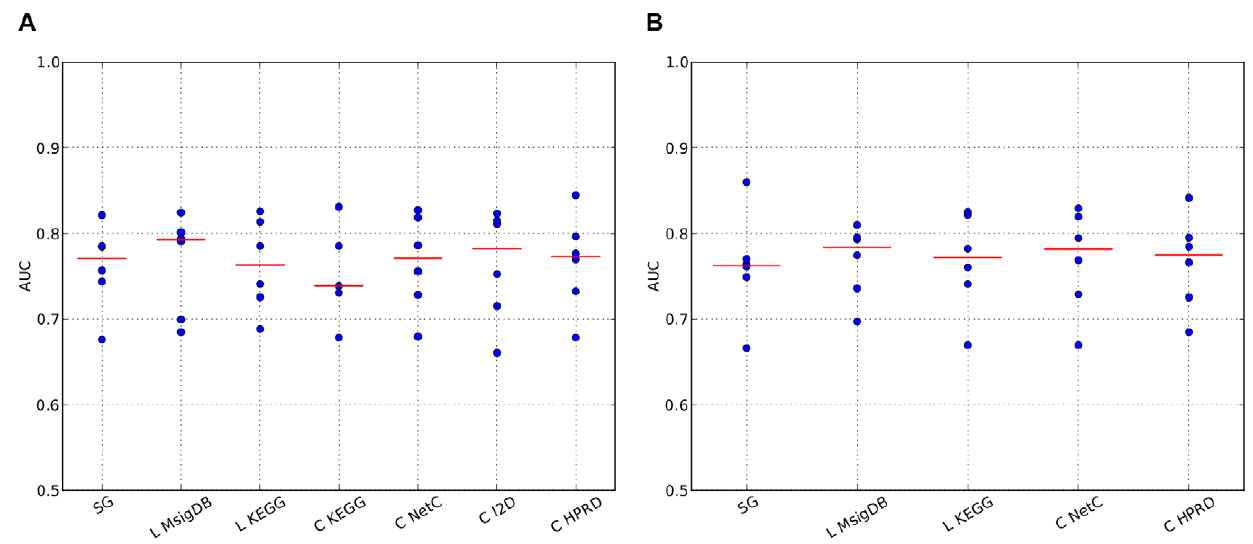
Figure 6. Classification results of the ER positive data only. The ER positive cases from a single data set were set aside as test set while ER positive cases from the remaining five data sets were merged into a single training set. This was repeated until each data set was employed as left- out test set, resulting in six AUC values. The red lines indicate the median. A : CV-optimized number of features; B : 50 best features.